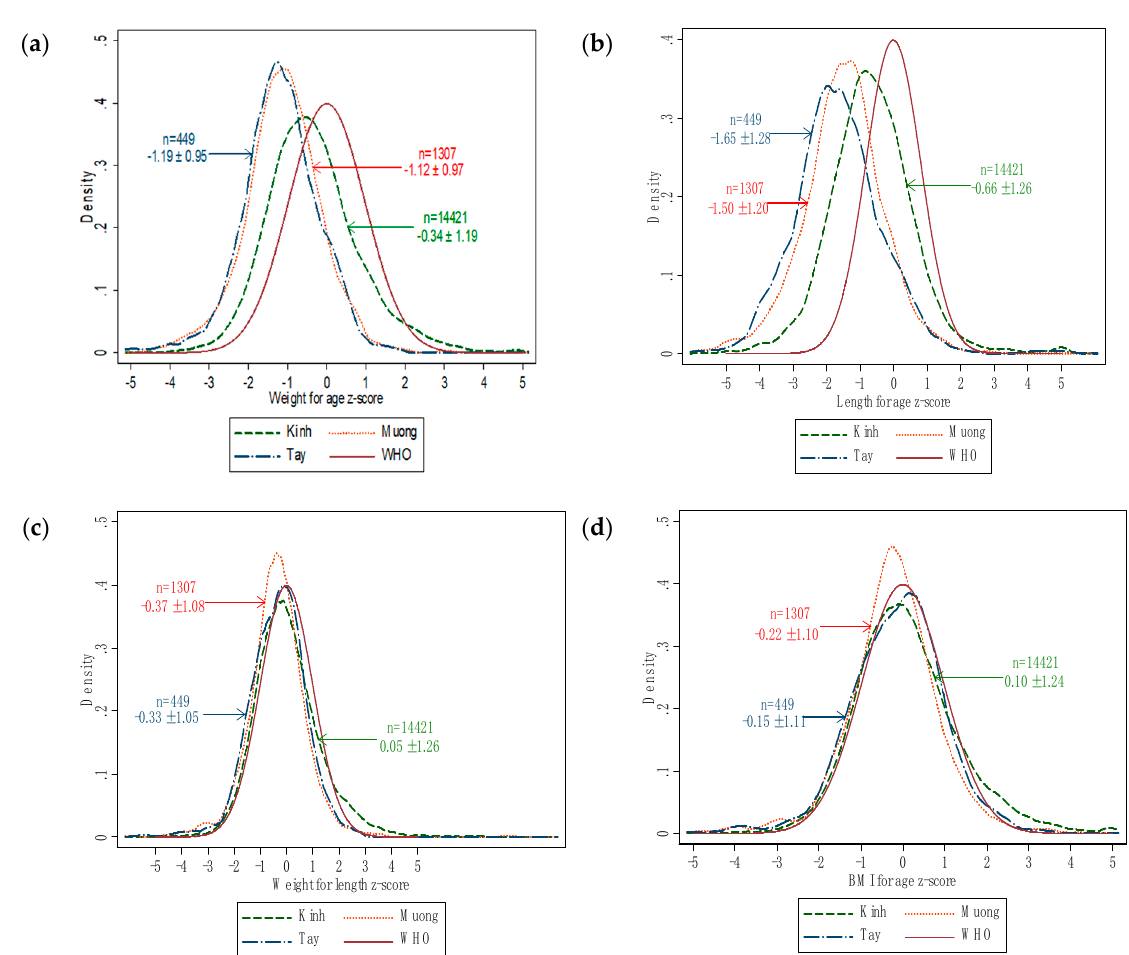
Figure 1. Distribution of weight-for-age ( a ), length / height-for-age ( b ), weight-for-length-for-age ( c ) and BMI-for-age ( d ) Z-scores across ethnic groups in comparison with WHO reference. (“ n ” is number of children in each ethnic group)